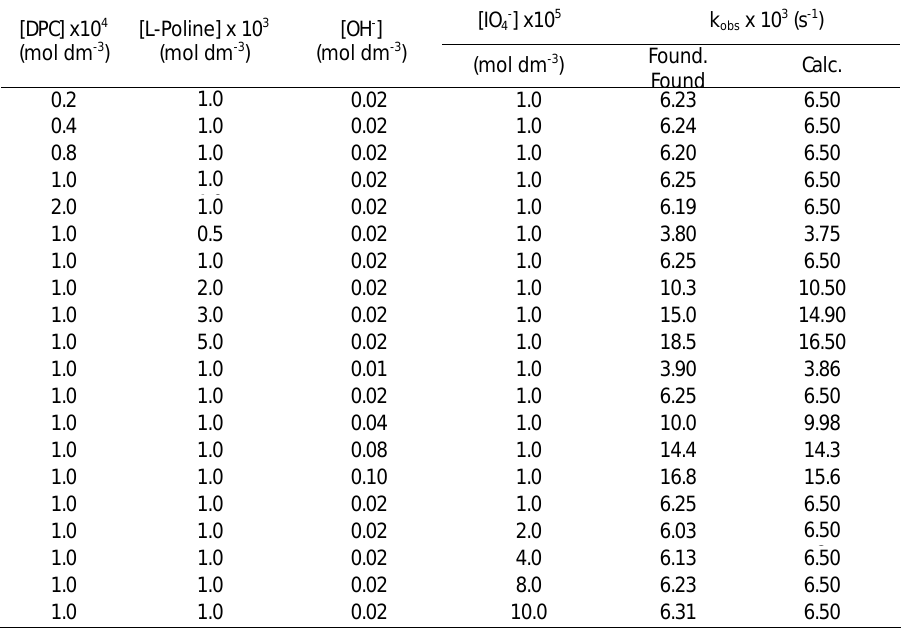
Table 1Table 1. Effect of variation of [DPC], [SAL], [OH - ], and [IO 4- ] on oxidation of L-Proline by DPC at 25°C, I = 0.10 mol dm -3